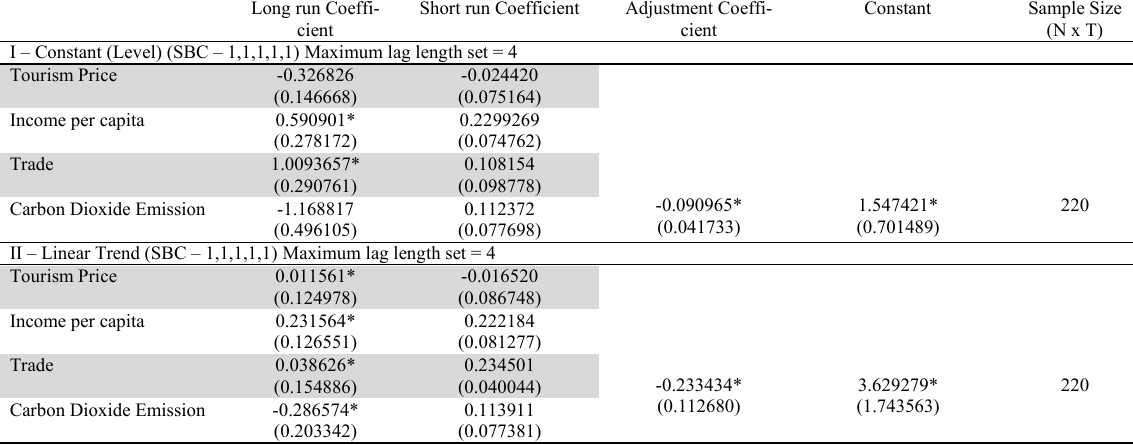
Long run Coeffi- Short run Coefficient Adjustment Coeffi- cient